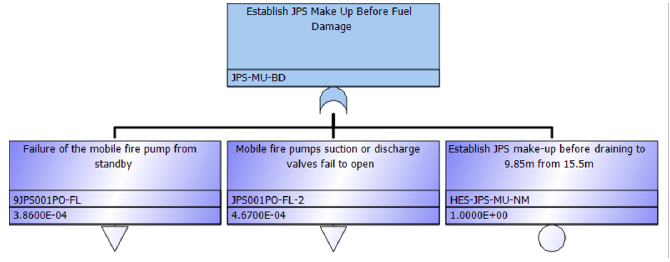
Figure 8. Failure Model of the JPS